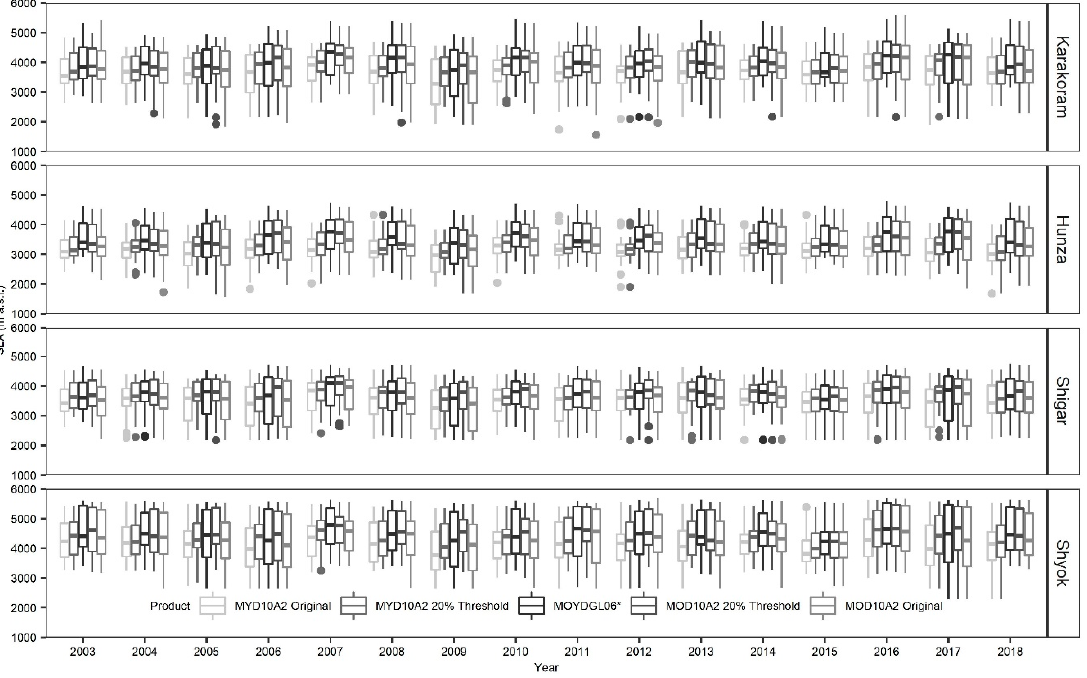
Figure 6. Boxplots illustrating interannual 8-day snowline altitude (SLA) variability derived from original products (M*Y10A2) and improved products (MOYDGL06*) in the Karakoram region and its subbasins. The dots represent values higher than 1.5 times the upper quartile and usually considered as outliers.